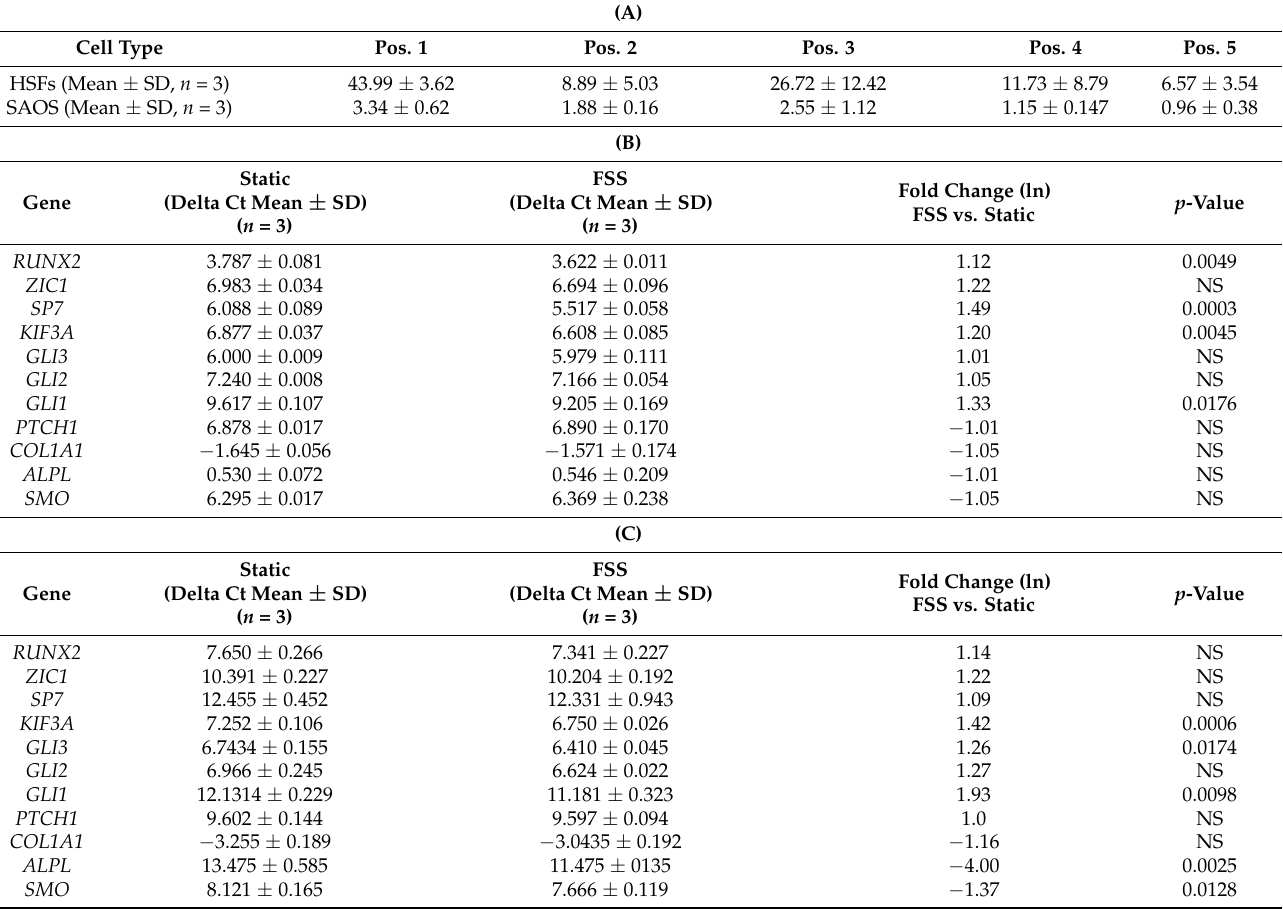
Table 4. ( A ) Comparison between ZIC1 promoter DNA methylation at five positions in primary human skin fibroblasts (HSFs) and osteoblast-like human osteosarcoma cell line (SAOS2 cells). ( B ) Effect of FSS on modulation of gene transcription/expression in osteoblast-like human osteosarcoma cell line (SaOS2 cells). ( C ) Effect of FSS on transcription in primary human skin fibroblasts (HSFs).